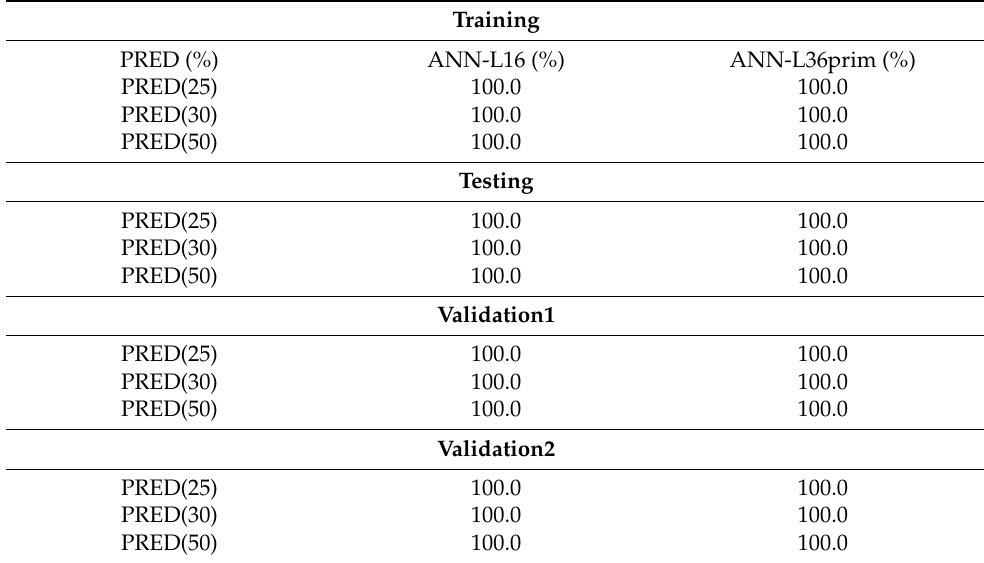
Table 9. Prediction values (UCP).